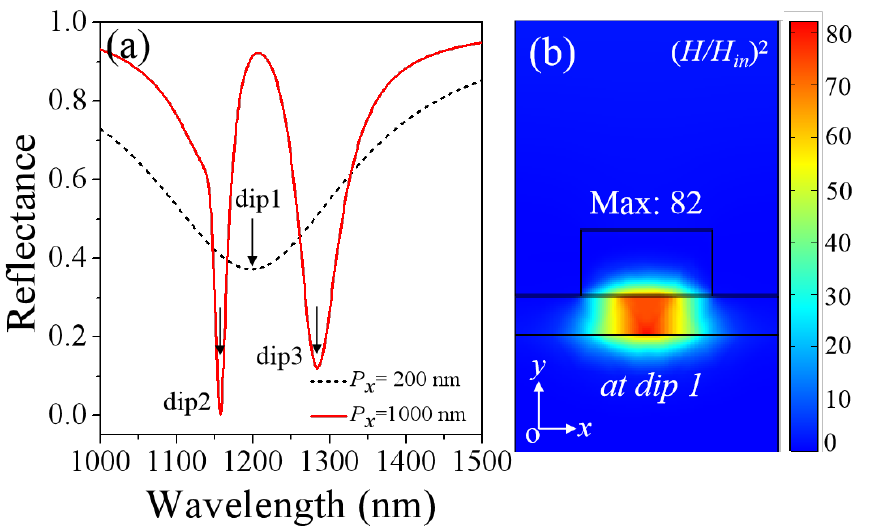
Figure 2. ( a ) The calculated reflection spectra of the designed metasurfaces with P x = 200 (black dotted line) and 1000 nm (red line), with the thickness of the BIG film t = 30 nm and the incident angle of θ = 8 0 . ( b ) The intensity distributions of normalized magnetic field ( H / H in ) 2 on the xoy plane for the dip 1 resonance. The boundaries of different materials are shown by the black solid lines.